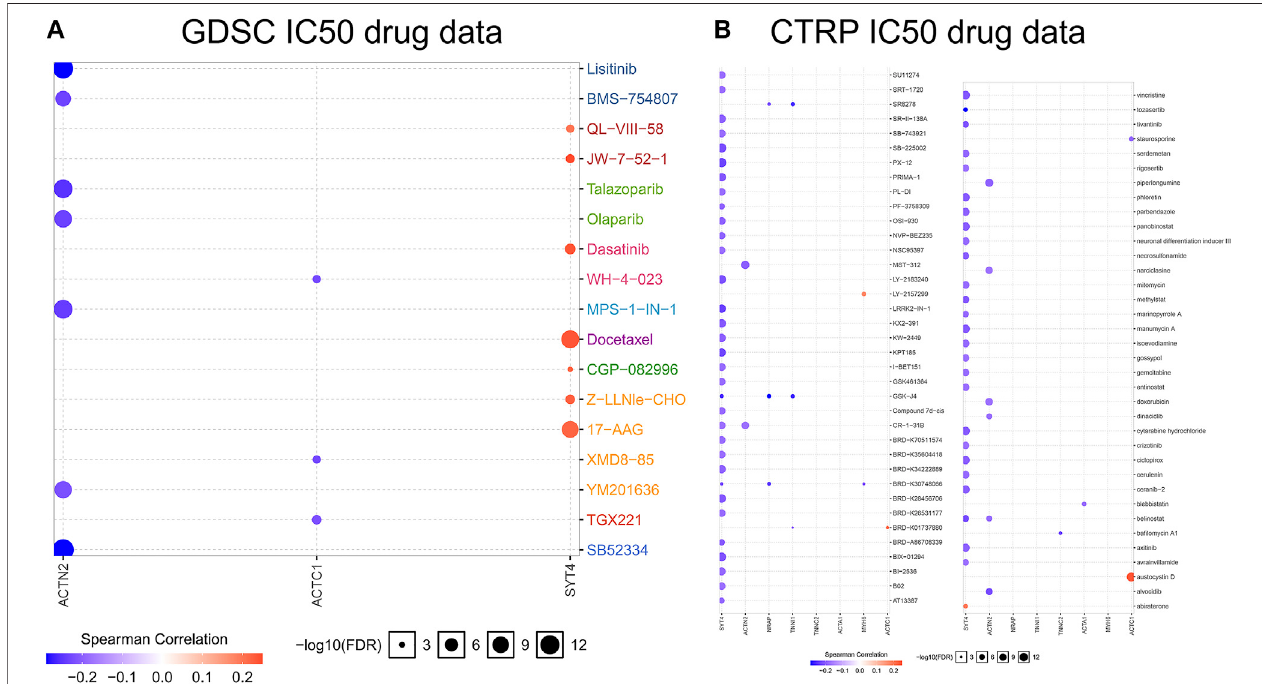
FIGURE 7 | Bubble heatmap which was obtained to describe the correlation between IC 50 data of different molecule drugs and the eight hub gene expression pro fi le in PCa cell lines. X -axis for FRGs, Y -axis for different drugs. (A) : GDSC IC50 drug data; (B) : CTRP IC50 drug data.